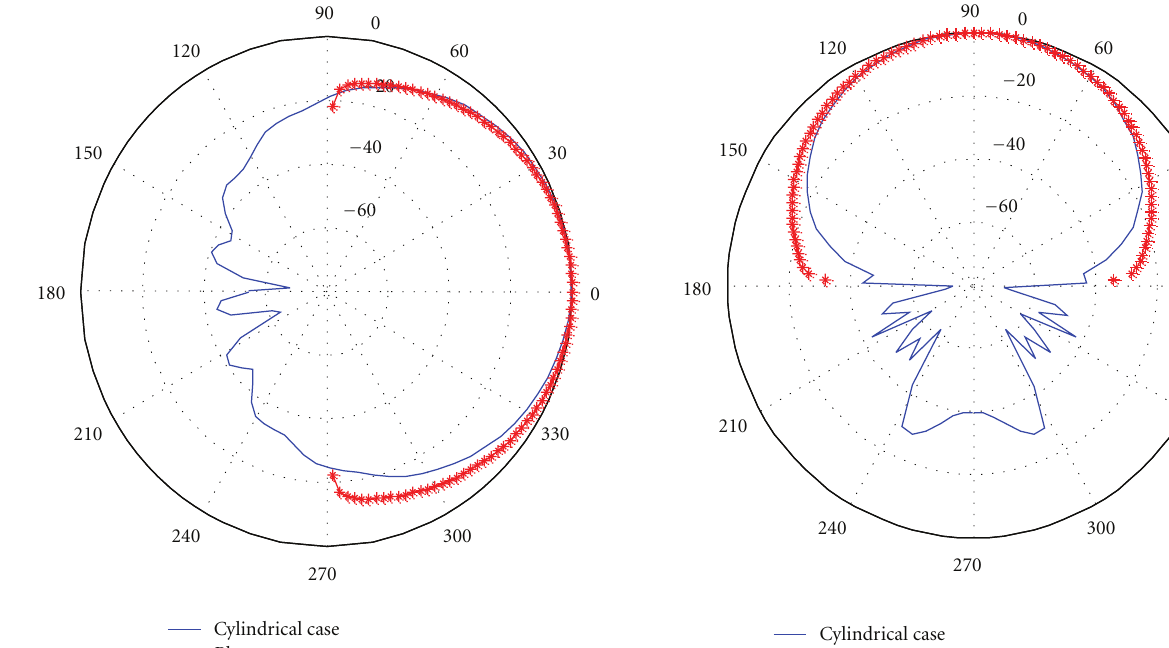
normalised radiation patterns are a ff ected by antenna patch’s curvature. It also shows that, comparing with the planar counterpart microstrip antenna, the reflection coe ffi cient of the CCMA increases, the current on the microstripline varies sharply, and the backward radiation field appears. However, the frontward radiation field is similar to the planar case. In order to improve the performance of the CCMA, the sizes of microstripline should be designed properly to match the impedance of